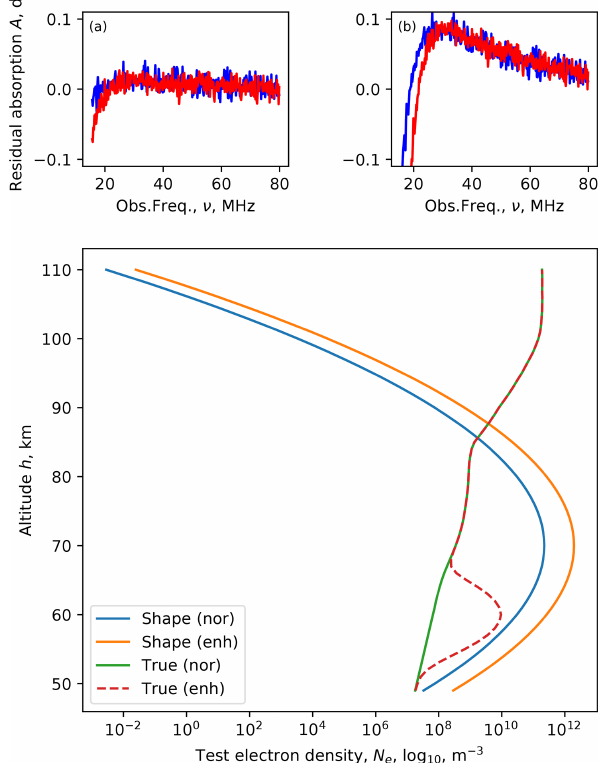
Figure 11. Fitting a 70km peak Gaussian electron density profile to simulated normal (nor) and enhanced (enh) ionospheric profile data. The residuals are shown in the two top panels as a function of the observing frequency: (a) normal and (b) enhanced, with the o mode shown in blue and the x mode in